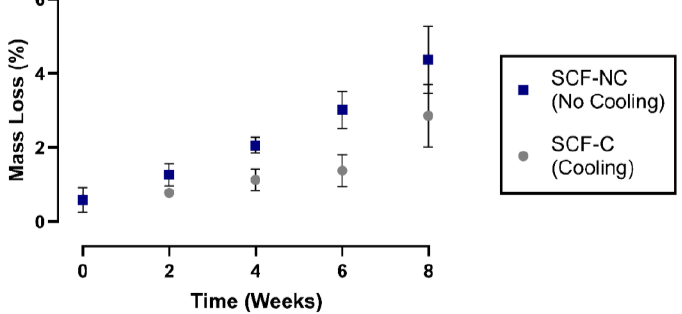
Figure 4. Mass loss percentage. At the end of the experiment, the SCF-NC samples lost 4.2% of their weight, while the SCF-C samples lost 2.5%.